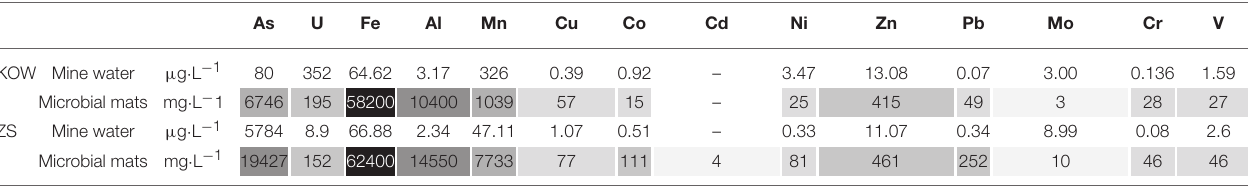
TABLE 1 | Heavy metal content in microbial mats and mine water in Kowary uranium mine and Zloty Stok gold mine.